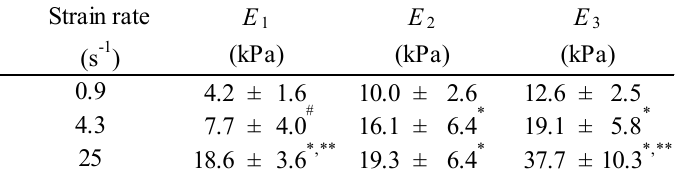
Fig. 4: Averaged stress-strain responses at three loading rates. Table 2: Young’s moduli of brain tissue obtained at three loading rates (mean ± SD).